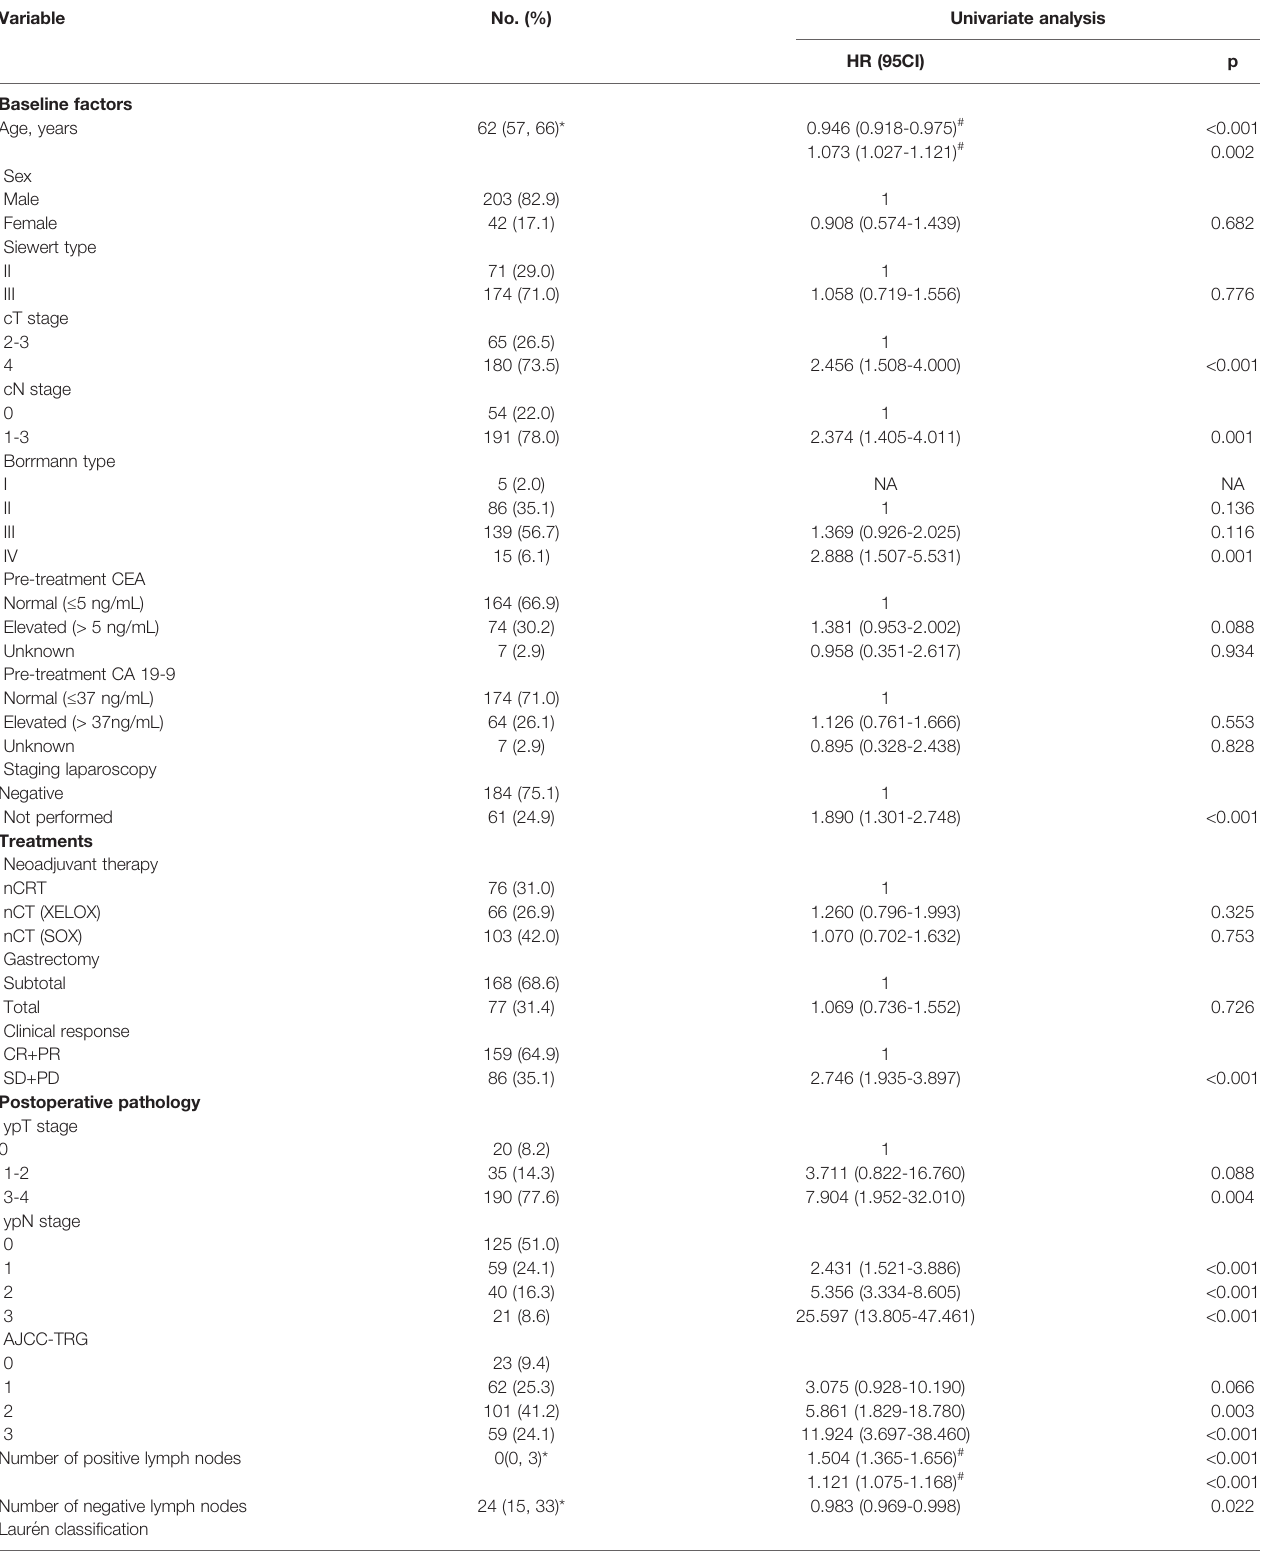
TABLE 1 | Demographic, treatment, and clinicopathological characteristics of patients and univariate analyses for disease-free